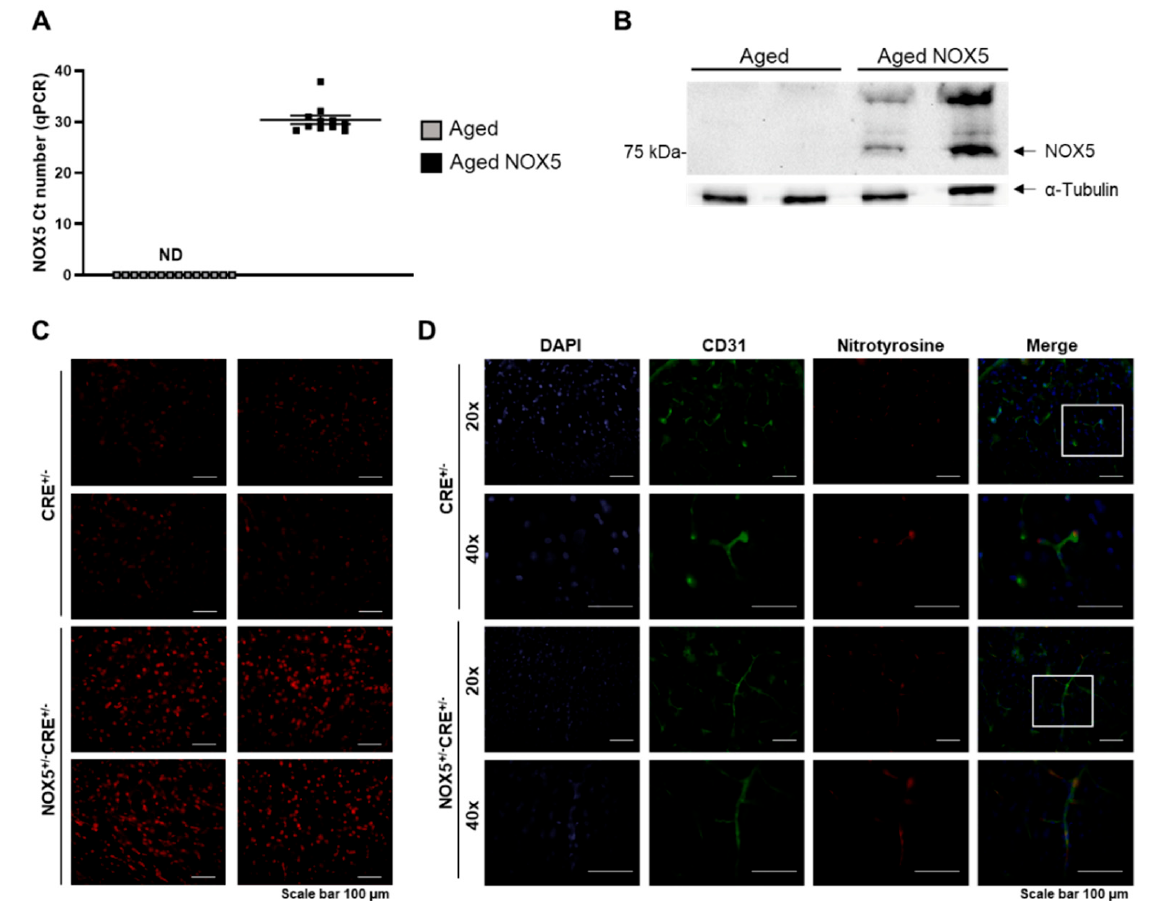
Figure 2. Characterization of the NOX5 knock-in mouse model. ( A ) NOX5 mRNA levels in the brain of aging mice expressing ( Aged NOX5 ) NOX5 in the endothelium vs . the control mice ( Aged ). n = 11–14. ND: nondetected. ( B ) Representative NOX5 and α -tubulin immunoblots in the lungs of aging mice expressing NOX5 in the endothelium ( Aged NOX5 ) vs . the control mice ( Aged ). ( C ) Intracellular superoxide anion production in young mice. Representative images (20×) obtained from the brain of young mice (2 months old) expressing NOX5 (NOX5 +/ − CRE +/ − ) and their controls (CRE +/ − ). ( D ) Nitrotyrosine accumulation in the young animals. Representative images obtained from the brains of young mice (2 months old) expressing NOX5 (NOX5 +/ − CRE +/ − ) and their controls (CRE +/ − ). The results are expressed as the mean ± SEM. Aged : CRE +/ − aging mice and Aged NOX5 : NOX5 +/ − CRE +/ − aging mice.